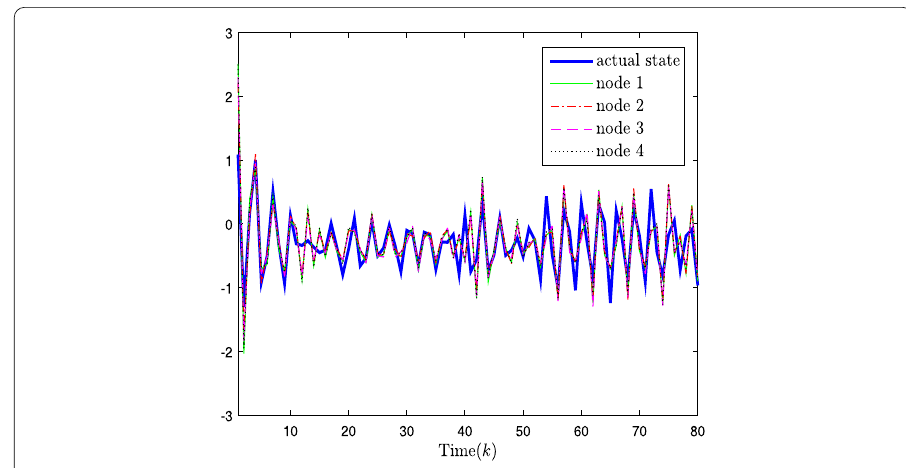
Figure 4 The actual state x 2, k and the corresponding estimates